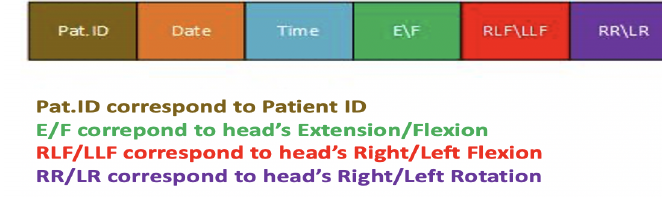
Figure 4. HeadUp data